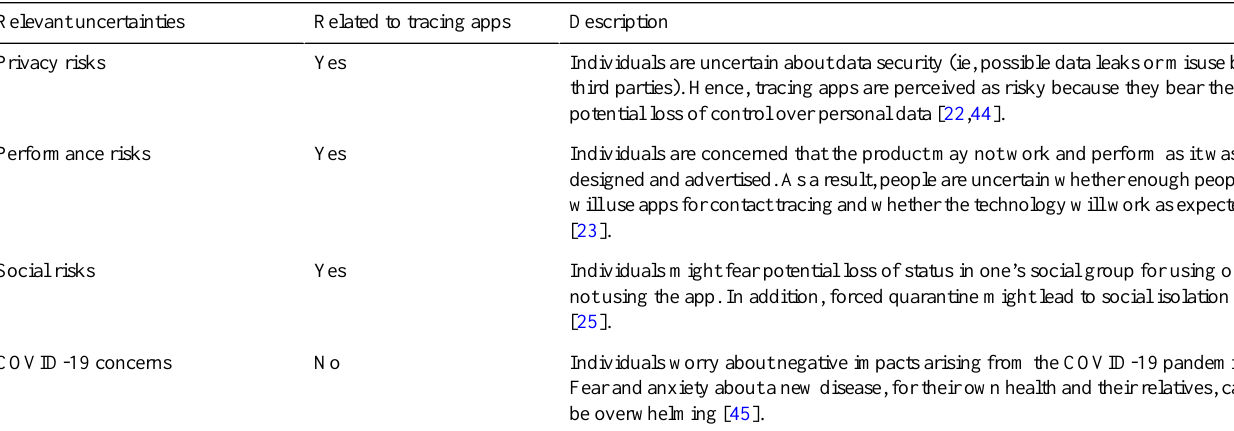
Table 1. Summary of relevant uncertainties in the context of COVID-19 tracing apps.